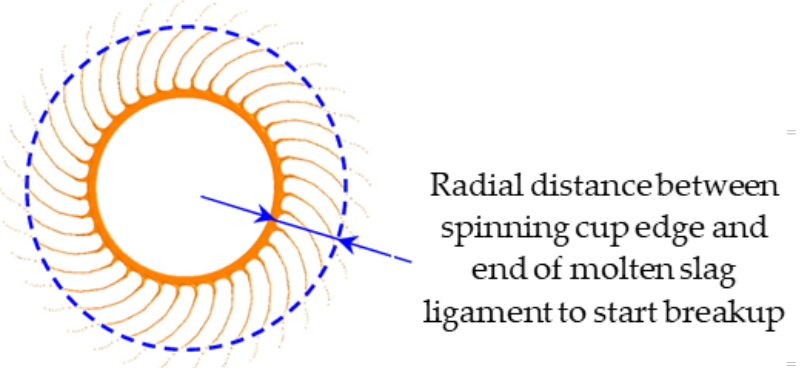
Figure 9. Definition of the radial distance between the spinning cup edge and end of molten slag ligament to the start of breakup.